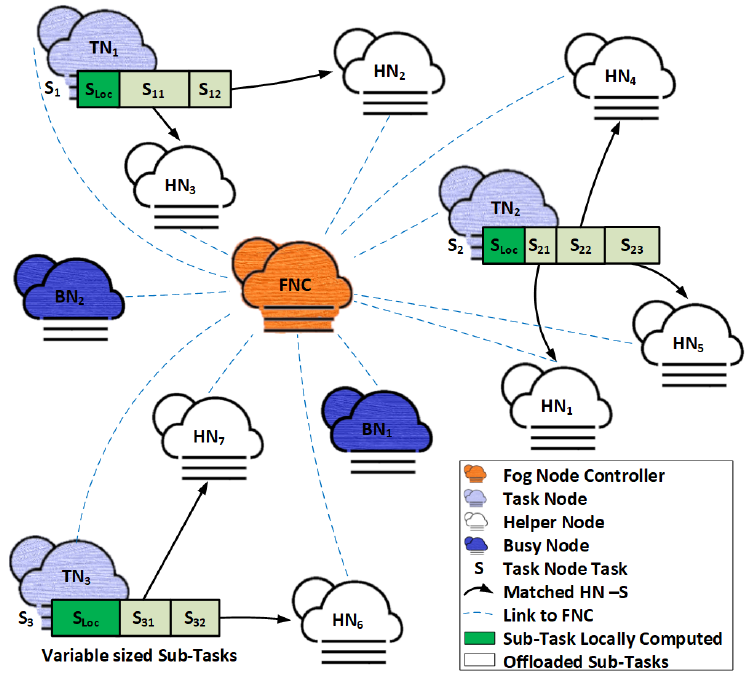
Figure 1. System